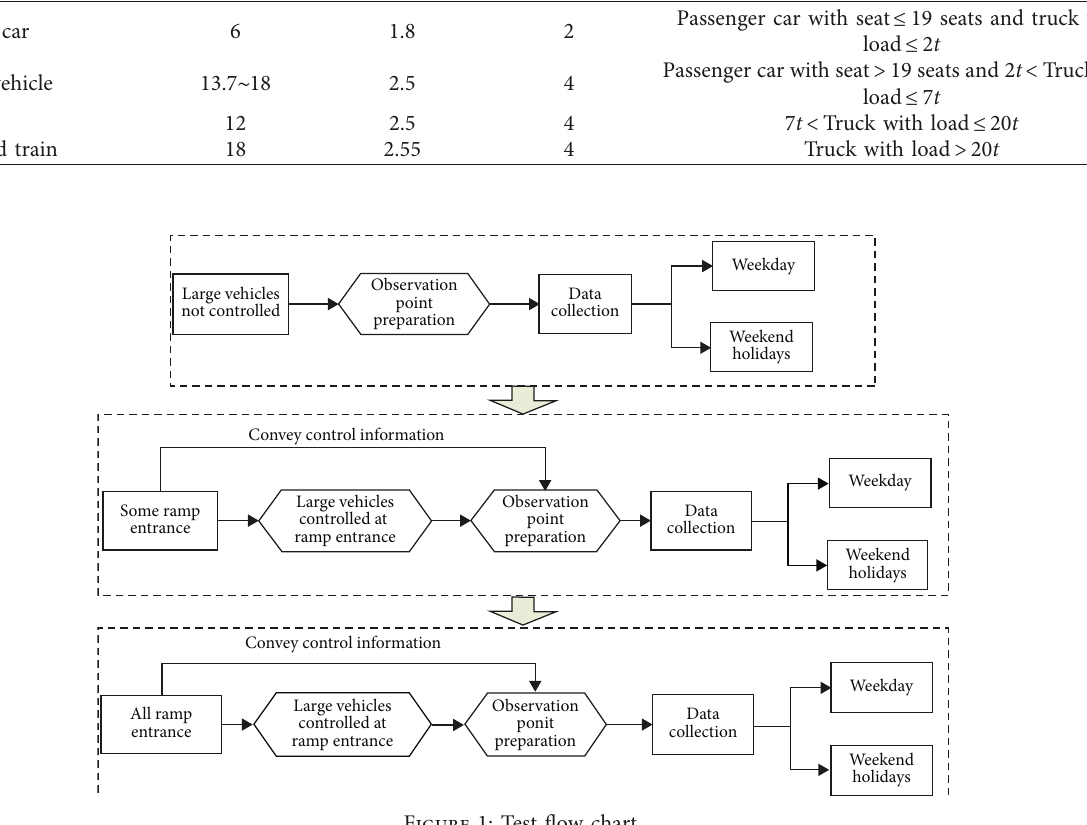
Figure 1: Test flow